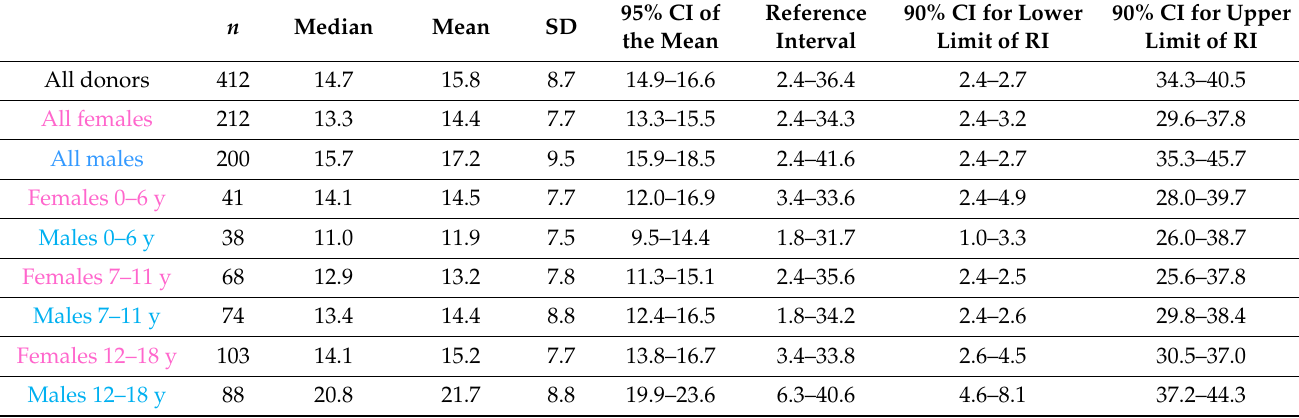
Table 1. ST2 results in ng/mL for all participants and categorized per age and sex. Mean, standard deviation, 95% confidence intervals of the mean, reference intervals and 90% CI of lower and upper limits are